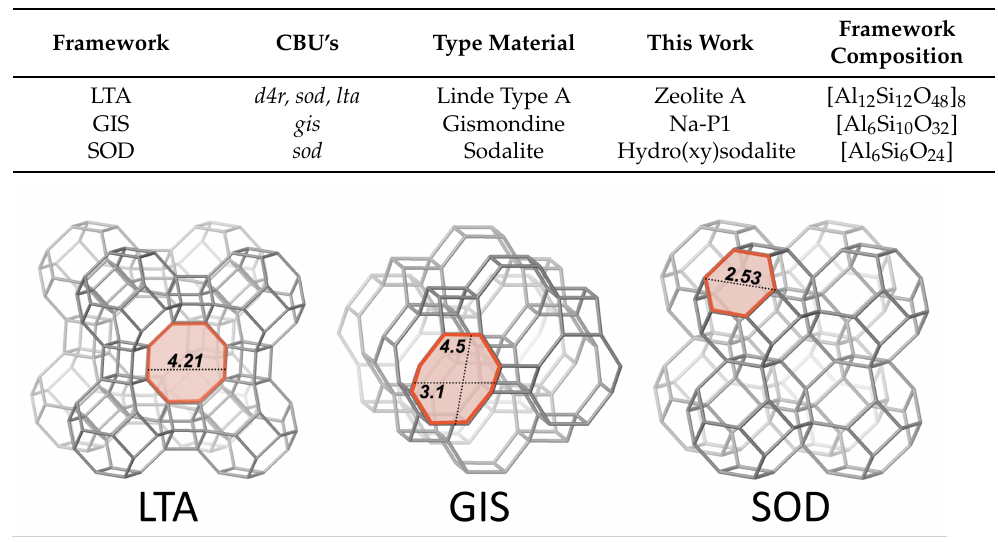
Figure 1. LTA-framework viewed along (100), GIS-framework viewed along (010) and SOD- framework viewed along (010). The respective largest window is highlighted in red and the numbers represent the dimensions in Å (modified after [40]).